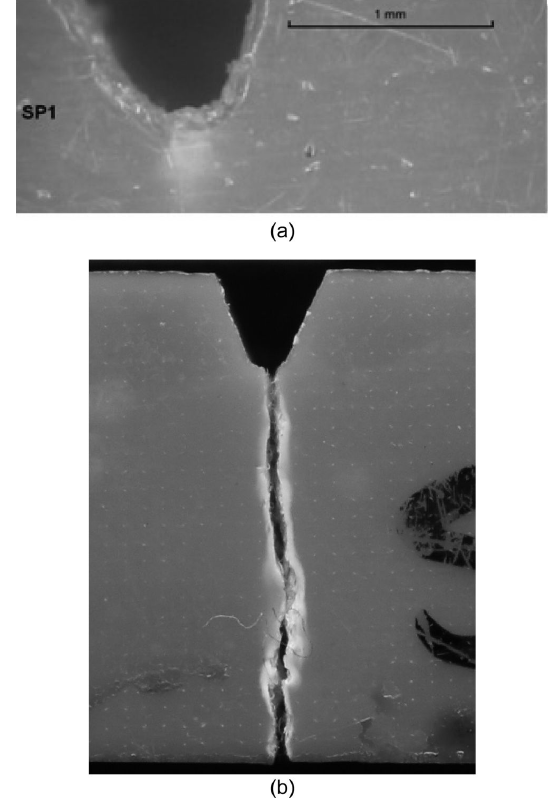
Fig. 6. (a) Stress whitening at root of notch prior to cracking (b) final crack.